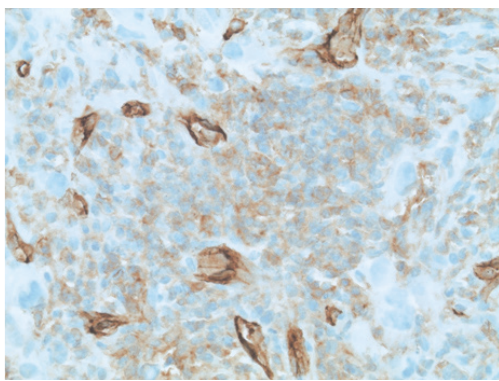
Figure 5: Intermediate power view of the tumour reflecting the spindled, sarcomatoid component (H&E stain, 200x original mag- nification).